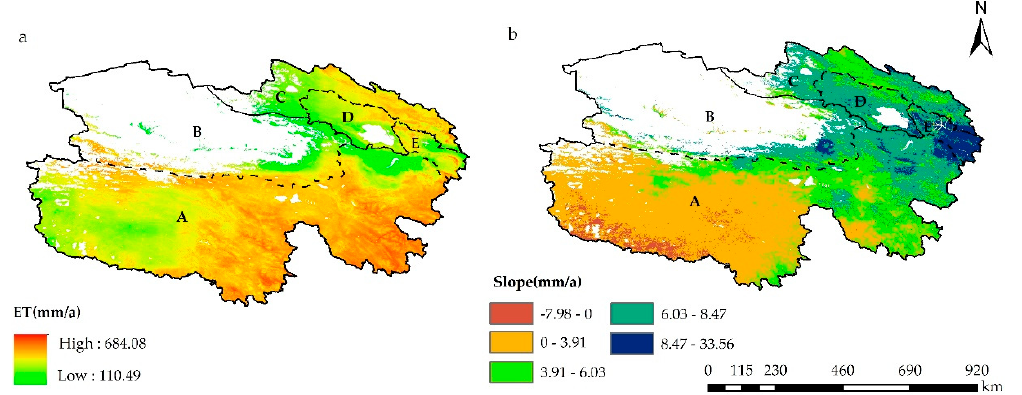
Figure 5. Spatial distribution ( a ) and changes ( b ) of ET in Qinghai Province during 2000–2020. A–E in the figure represents the Three-River Source region, the Qaidam Basin region, the Qilian Mountain region, the region around Qinghai Lake, and the Hehuang region, respectively.